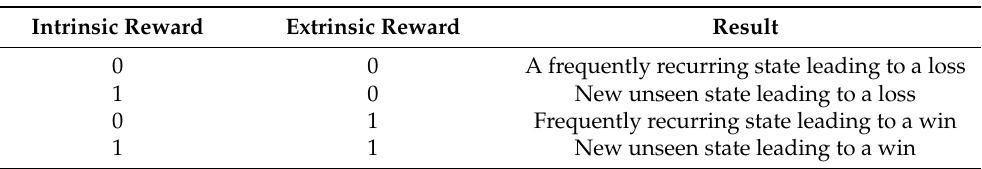
Table 1. The logic of combining intrinsic with extrinsic reward elucidated through examples of extreme value combinations and the novelty of the current state in relation to task completion, as depicted in further